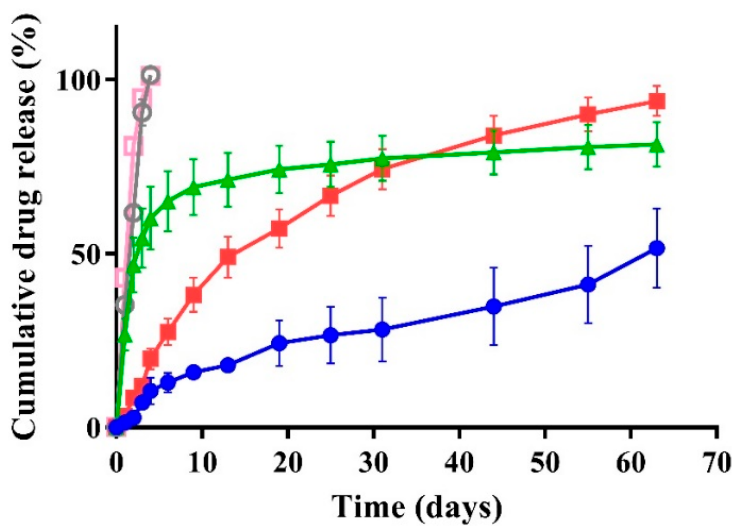
Figure 5. Release profile of dexamethasone from pullulan-dexamethasone under three different conditions: PBS pH 7.4 ( ● ); 1:1 v / v homogenized vitreous: PBS, pH 7.4 ( ■ ); phosphate-citric buffer, pH 5.0 ( ▲ ). Free dexamethasone in PBS, pH 7.4 ( ○ ) and in 1:1 v / v homogenized vitreous:PBS, pH